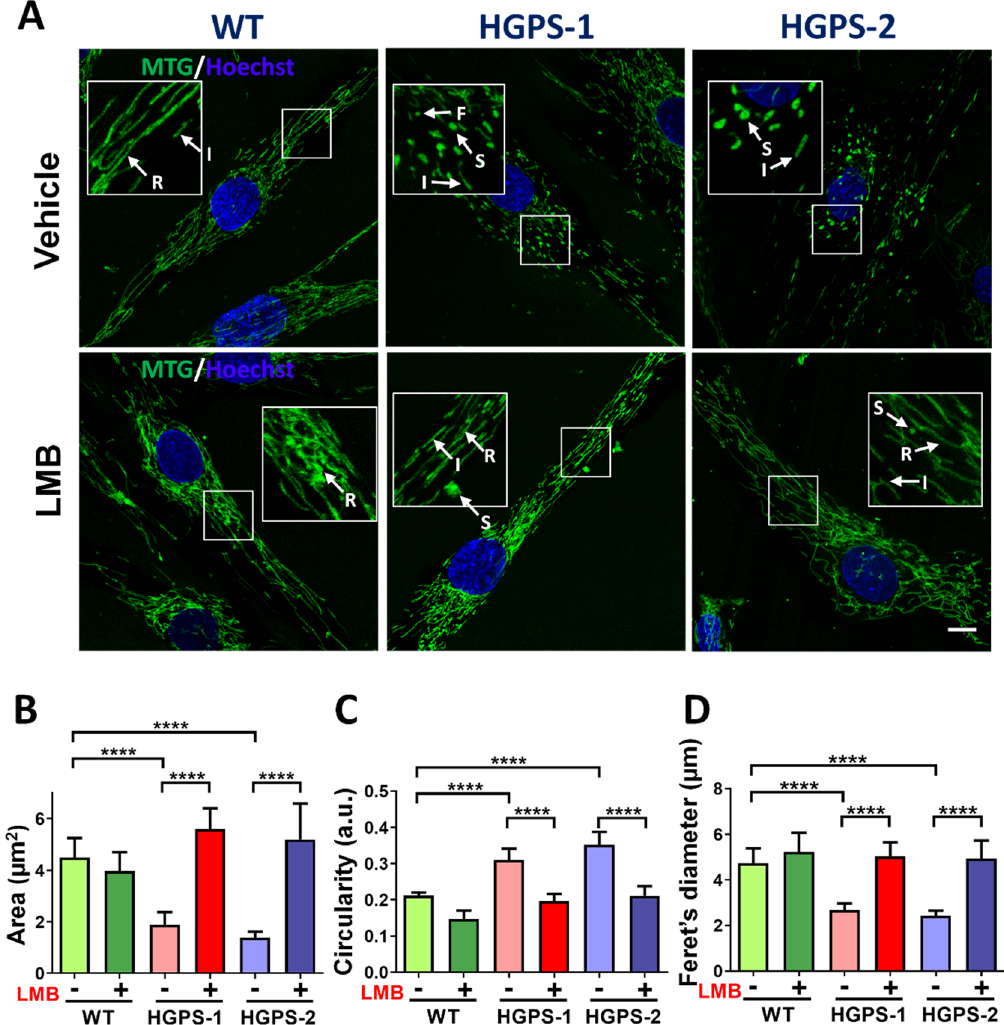
Figure 1. Treatment with LMB recovers mitochondrial morphology in HGPS cells. ( A ) WT, HGPS-1, and HGPS-2 primary fibroblasts grown on coverslips were treated for 3 days with 1 nM LMB or the vehicle alone, and then subjected to MTG staining. Nuclei were labeled with Hoechst prior to confocal microscopy analysis. Typical fluorescence images of MTG-stained mitochondria are shown. Arrows indicate; F: fragmented; I: intermediate; R: reticulate; and S: swollen mitochondria. Scale bar, 10 µm; insets, 4×. ( B – D ) Morphometric analysis of mitochondria from WT and HGPS 1-2 cells was conducted to calculate area, circularity, and Ferret’s diameter parameters. Results correspond to the mean +/ − SD from three separate experiments (n = 80 cells per condition) with significant differences determined by unpaired t test (n = 50 cells per experimental group; **** p < 0.0001).